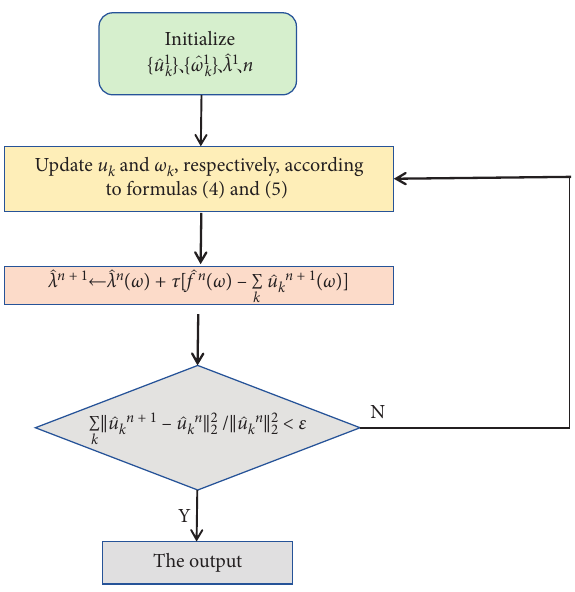
Figure 1: Specific steps of VMD